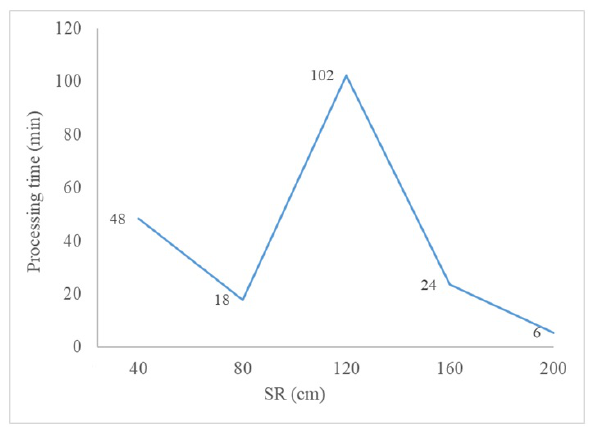
Figure 8. Processing time at different SRs